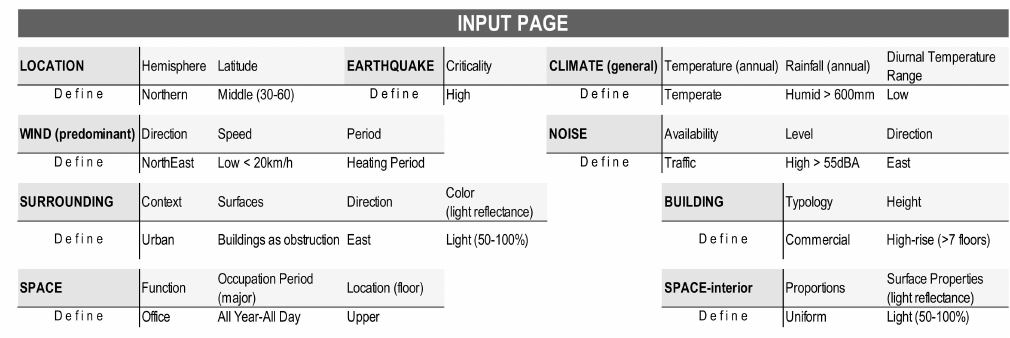
Figure 2. Input page (screenshot from the